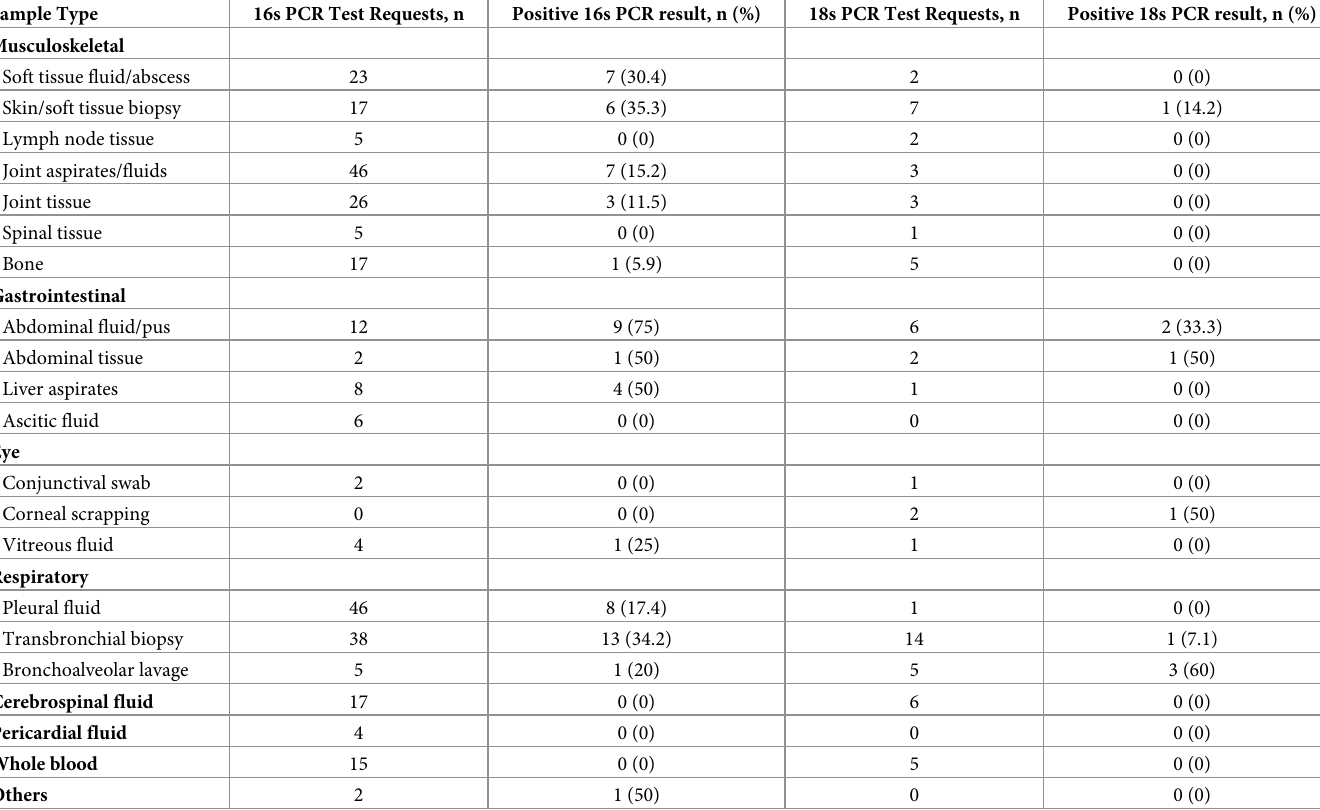
Table 1. 16s/18s PCR test requests and positivity rate per sample type. Sample